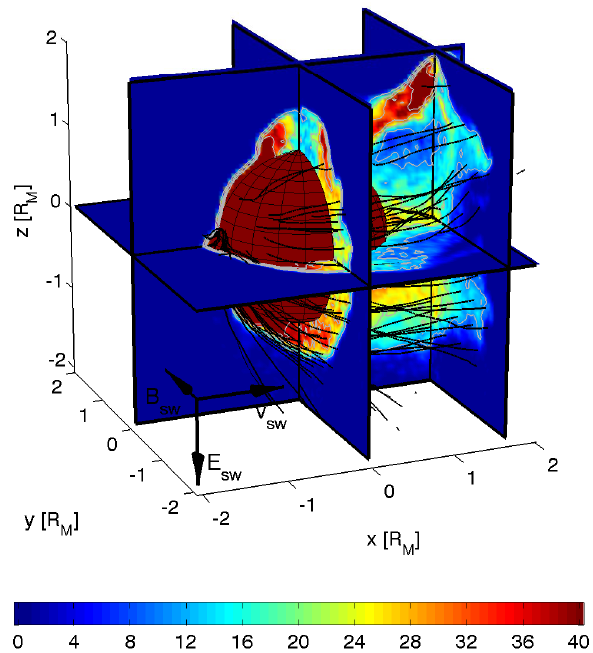
Fig. 9. Simulation results for the “standard run” continued. The cut- ting planes show the magnetic field in nT. The black solid lines rep- resent the magnetic field lines. The magnetic field lines are draped around the obstacle. Just in front of the ICB, the magnetic field reaches its maximum, which indicates the “magnetic pile-up bound- ary” (MPB). The magnetic field vanishes inside the wake in the po- lar plane. The full three-dimensional structure in the tail is again highly asymmetric and complicated. The same shocklet substruc- turing as in Fig. 7 can be seen downstream of the